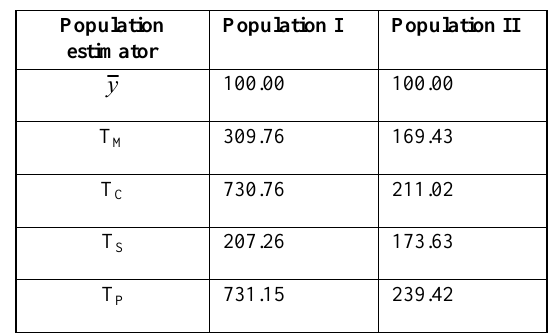
Table 1. Relative efficiency of proposed and existing